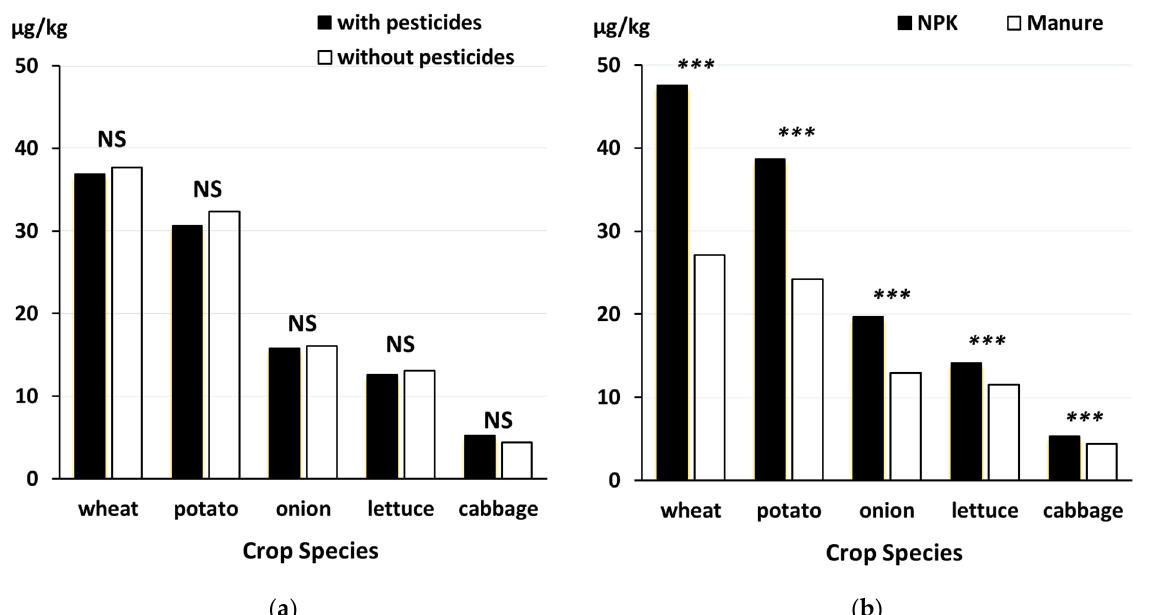
Figure 4 . Effect of contrasting ( a ) crop protection (with and without the use of synthetic chemical pesticides) and ( b ) ferti- lization regimes (mineral NPK versus manure applied at the same total N-input rate of 170 kg N hectare) used in organic and conventional farming on cadmium concentrations in wheat grain, potato tubers, onions, cabbage heads and lettuce leaves Data from [58,65]. Bars represent the main effect means of data from four (potato, onion, lettuce, cabbage) or five (wheat) growing seasons. ***, significant difference ( p < 0.001); NS, not significant.